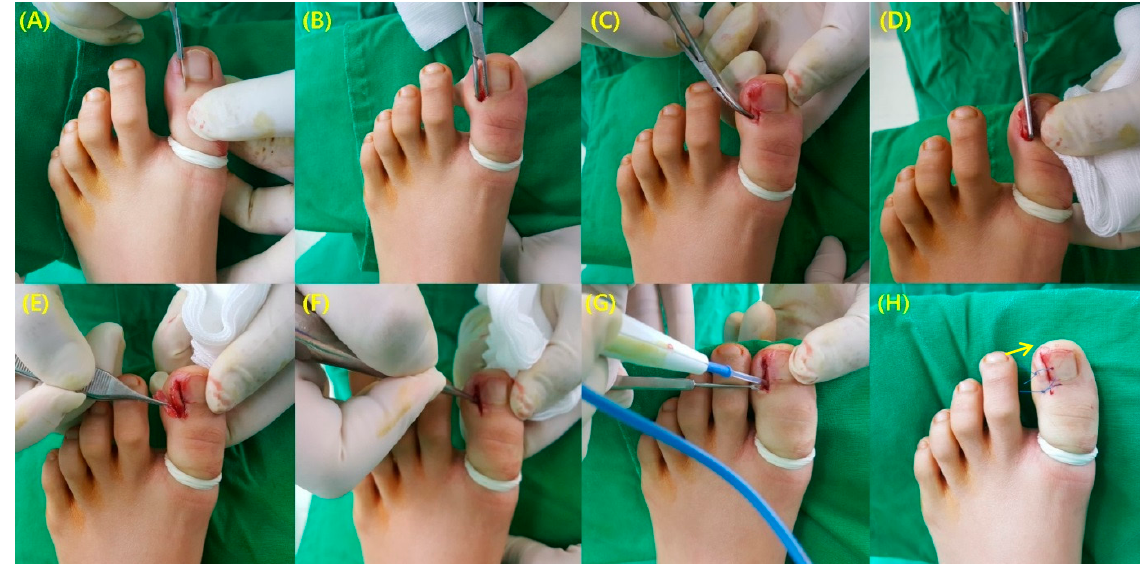
Figure 1. Sequences of operative procedure ( A ) Less than 10mm incision made at the eponychium. ( B ) Blunt dissection to separate the soft tissue from the ingrown part of the nail. ( C ) Exposure of the overgrown nail plate. ( D ) Partial excision of the nail plate. ( E ) Excised portion of the nail plate (1/4 to 1/5 of the nail). ( F ) Curettage of the germinal matrix and nail bed. ( G ) Additional destruction of germinal matrix using electrocautery. ( H ) One nylon suture was performed to attach the resected eponychium. In case of unstable nail plate following the gentle, blunt dissection of the soft tissue, additional distal suture was made to stabilize the nail plate (arrow).